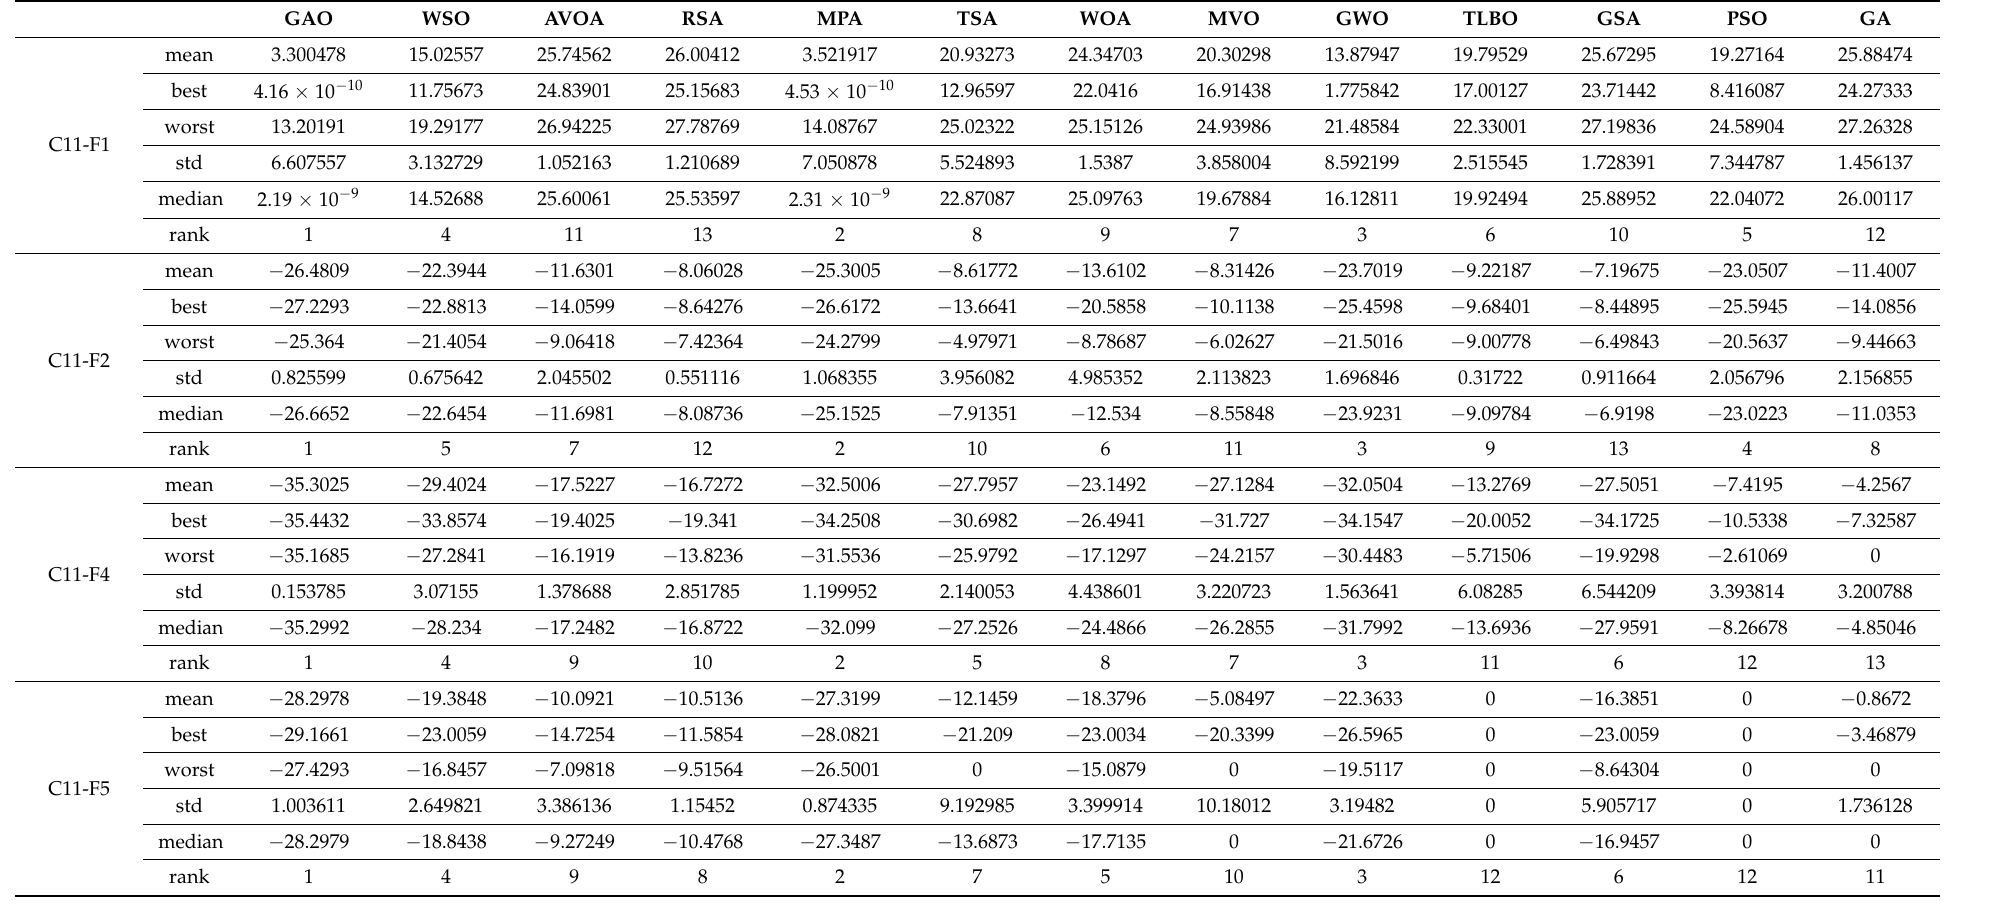
Table 8. Optimization results of the CEC 2011 test